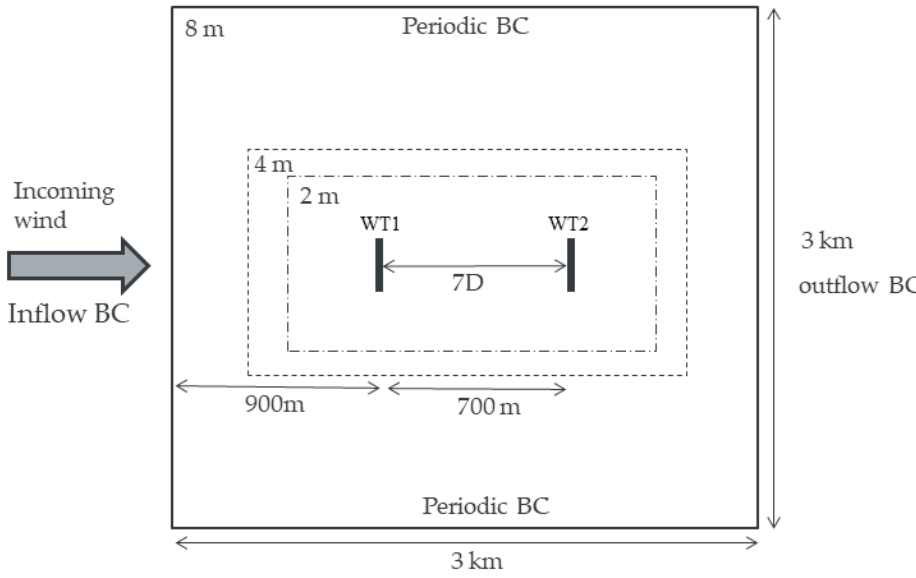
Figure 4. Horizontal projection of computational domain for planar data extraction.